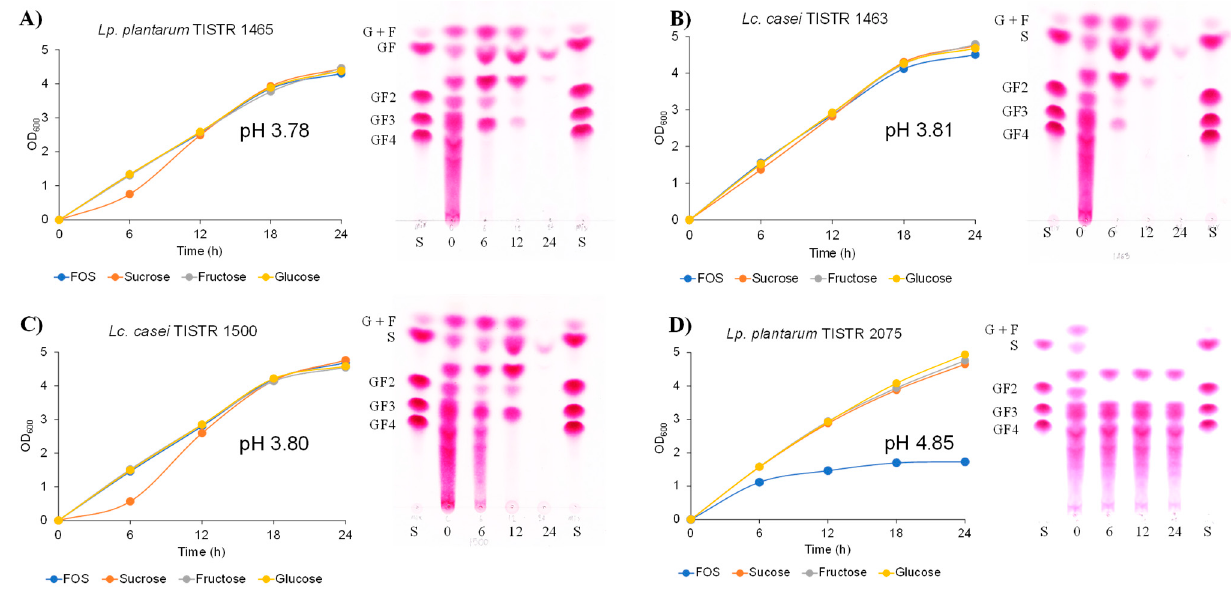
Figure 3. Growth and TLC chromatogram of different probiotic Lc. casei TISTR 1463 ( A ), Lp. plantarum TISTR 1465 ( B ), Lc. casei TISTR 1500 ( C ) and Lp. plantarum TISTR 2075 ( D ) when cultivated in inulin-FOSs extract at 37 °C for 24 h.